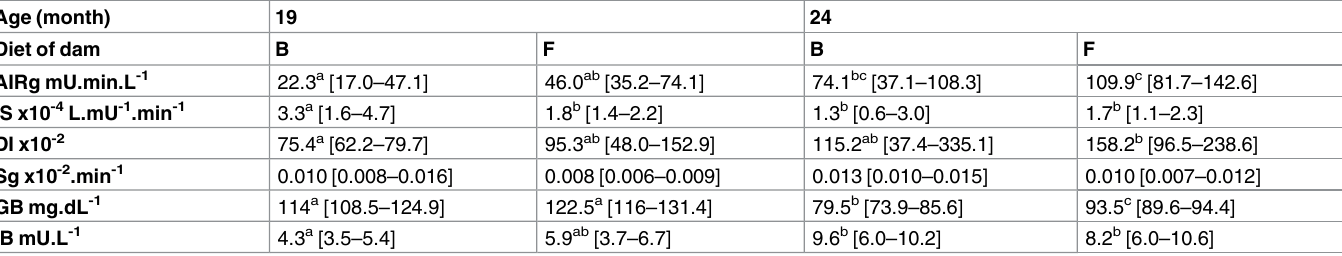
Table 6. Effects of the feeding challenge and age (median and IQR) on acute insulin response to glucose (AIRg), insulin sensitivity (IS), disposi- tion index (DI) and glucose effectiveness (Sg), basal plasma glucose (GB) and basal plasma insulin (IB) in yearlings whose dams were fed with barley and forage (B, n = 10) or forage only (F, n = 10), at 19 and 24 months of